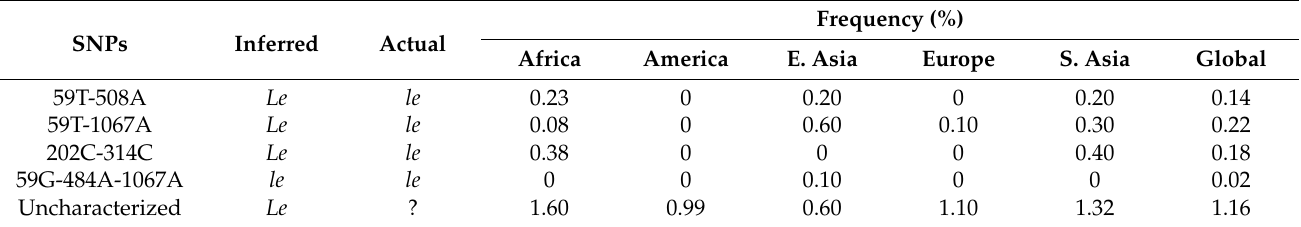
Table 4. FUT3 alleles whose Lewis phenotype may be misjudged by the present FMCA